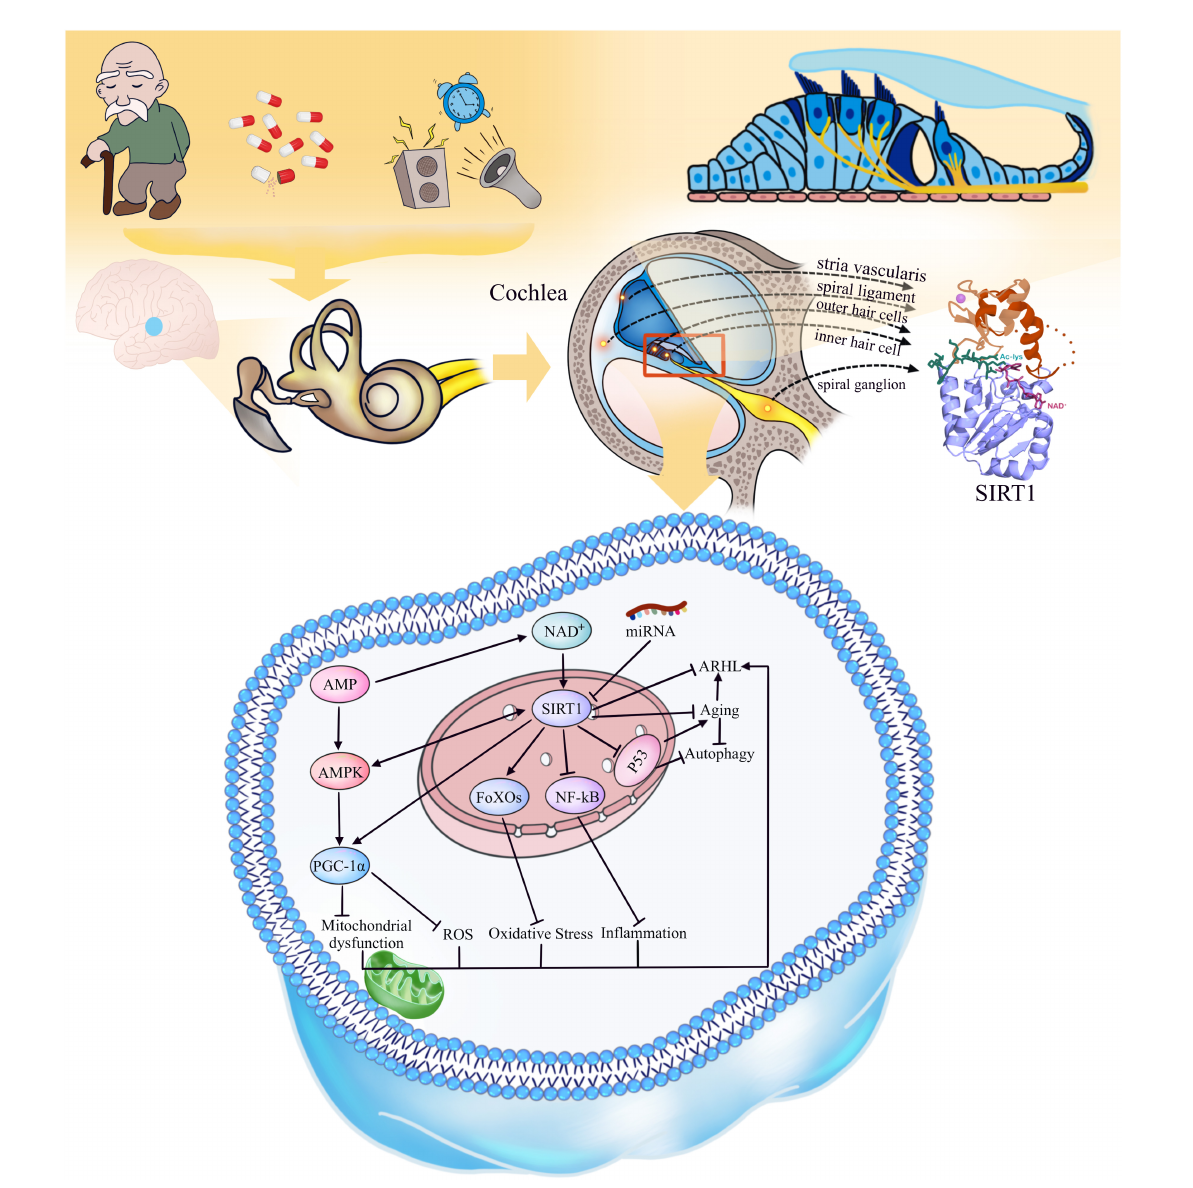
FIGURE1 Aging and environmental factors lead to the decline of auditory center and inner ear functions, resulting in ARHL. Distribution of SIRT1 in cochlea: SIRT1 is expressed in inner and outer hair cells, spiral ligament, margin cells and intermediate cells of stria vascularis, and spiral ganglion cells of cochlea. The function of SIRT1: SIRT1 is regulated by NAD + , AMPK is regulated by AMP, and AMPK and SIRT1 can promote each other, while some specific miRNAs can inhibit the activity of SIRT1. SIRT1 can activate PGC-1 α and FoXOs, enhance the resistance to oxidative stress damage, keep the normal function of mitochondria; SIRT1 can also deacetylate to reduce the activity of NF- κ B, p53 and other inflammatory and aging-related factors to reduce their activity and promote the increase of autophagy. As a consequence, SIRT1 can delay the aging and age-related hearing